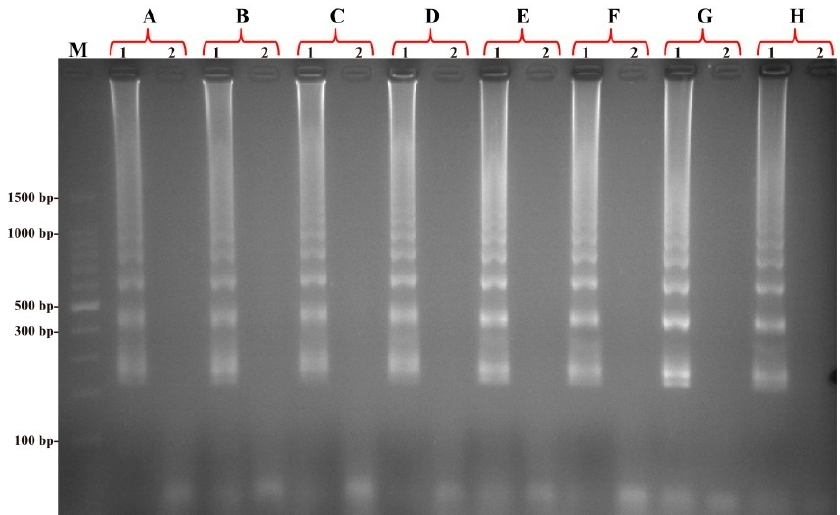
Figure 8. Products of MIP-LAMP monitored using 2.5% agarose gel electrophoresis. The products ( A – H ) of MIP-LAMP from different reaction temperature (60–67 °C) were monitored by 2.5% agarose gel electrophoresis after staining with ethidium bromide. Lane M, DL 100-bp DNA marker; lane 1, positive MCDA products; lane 2, negative control (no DNA).